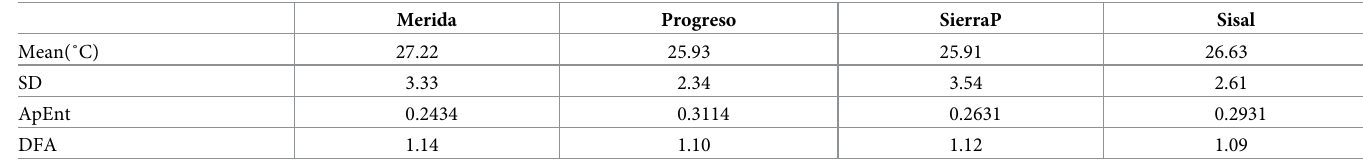
Table 1. Descriptive statistics and complexity quantifiers for the cities analyzed in the Yucatan